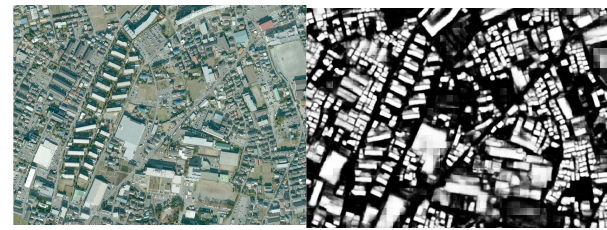
Figure 6. Predicted map patch in Saitama District year 2012 after undergone semantic segmentation by CNN 3.2 Mapping onto 5D world map